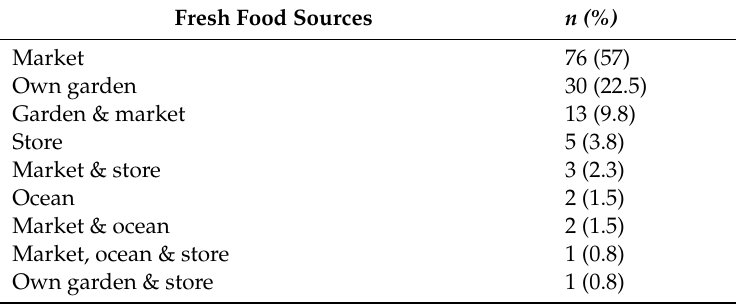
Table 3. Reported sources where participants access fresh